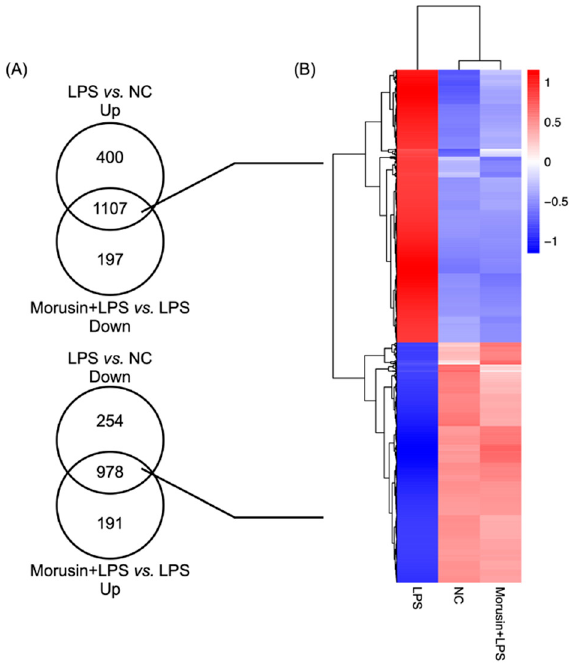
Figure 2. Overview of the differentially expressed genes (DEGs) in ruminal epithelial cells (RECs) among different treatments. ( A ) Venn diagrams of DEGs based on the comparisons of different treatments. Cut-off for the differential expression was determined as p adj < 0.05 and fold change > 2. ( B ) Hierarchical clustering of overlapping DEGs among different treatments. The color code indicates the gene expression level, red represents highly expressed genes, and blue represents lowly expressed genes. RECs were treated without (NC, n = 4) or with 0.1 µg/mL lipopolysaccharide for 3 h after pretreating with 50 µg/mL of Morusin for 12 h (Morusin+LPS, n = 4) or not (LPS, n = 4).